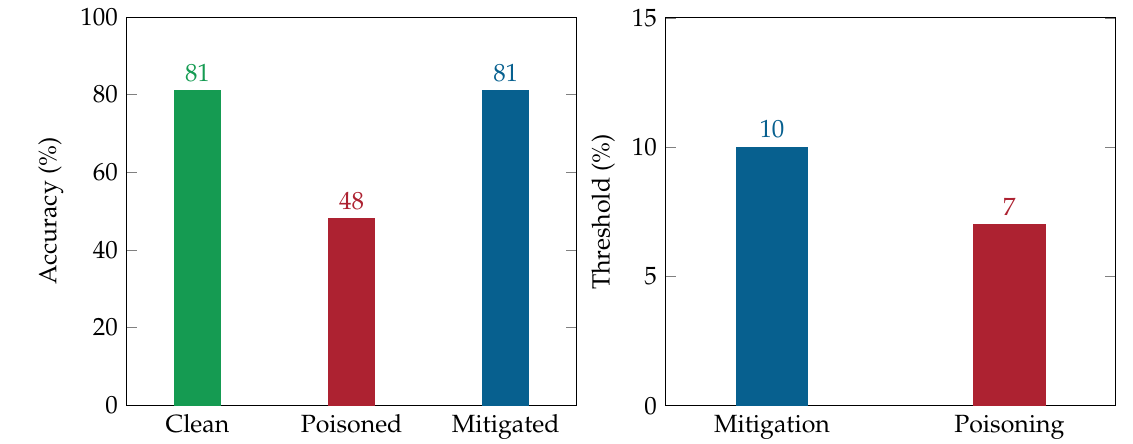
Figure 3. Static Relabeling